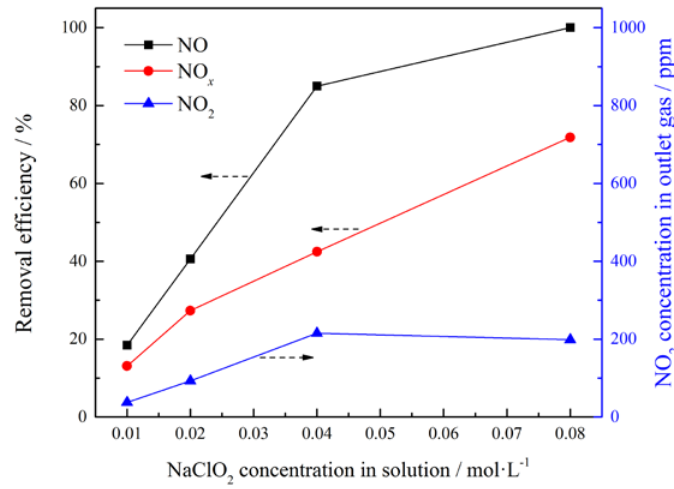
Figure 6. The change of the NOx removal efficiency and outlet NO 2 concentrations with NaClO 2 concentration in the solution.